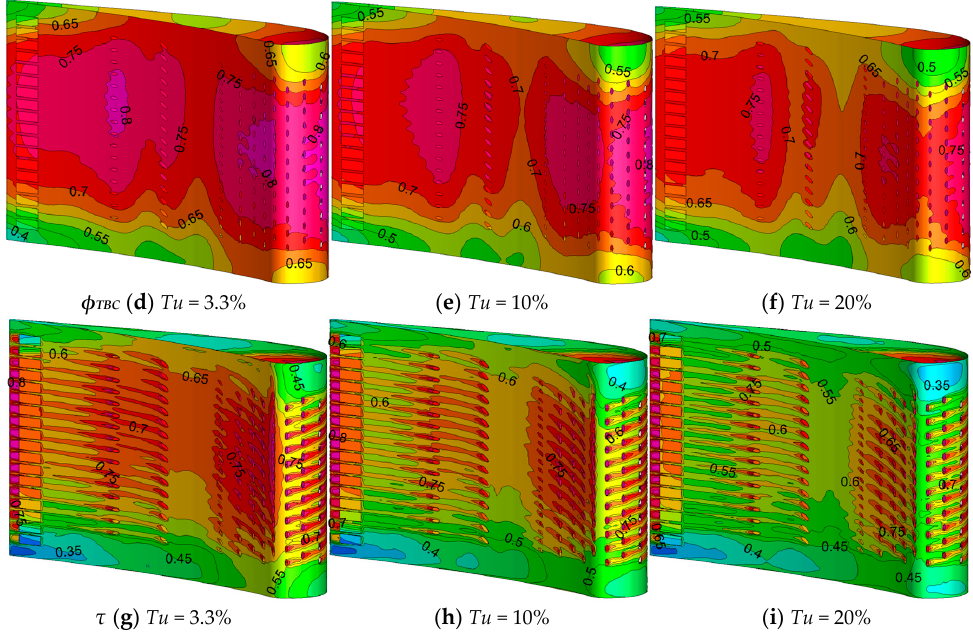
Figure 7. Contours of ( a – c ) φ ; ( d – f ) φ TBC ; ( g – i ) τ on the pressure side (PS) at three Tus .